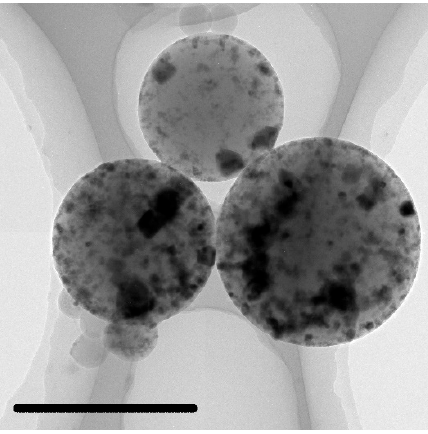
Figure 10. Image of C@Fe 3 O 4 (MC-3), the scale bar was 5 μ m.